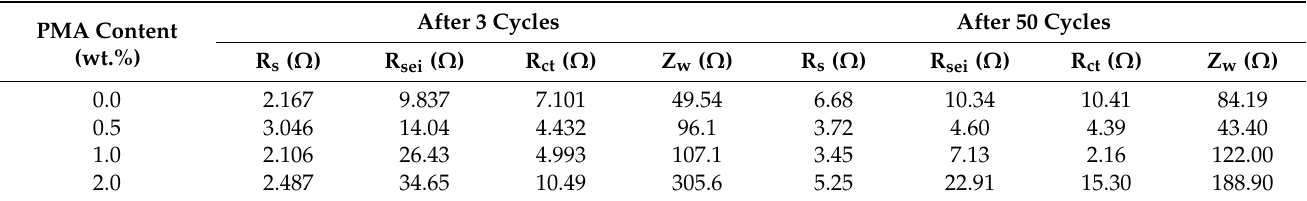
Figure 9. Nyquist plots of MCMB electrodes after cycled in the base electrolyte containing different concentrations of PMA additive for ( a ) 3 cycles and ( b ) 50 cycles at 55 ◦ C. Table 1. EIS fitting results obtained from Nyquist plots of MCMB.